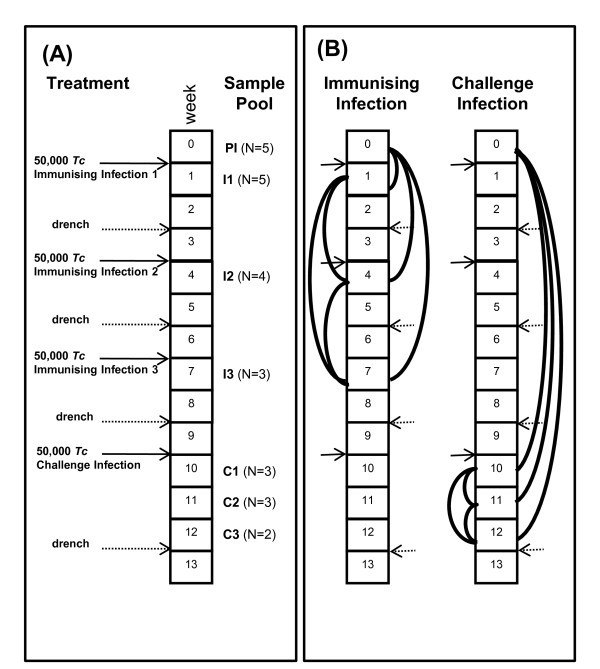
Experimental Design. (A) Truncated Immunising infection and Challenge protocol. Daily afferent lymph samples were collected over a 13 week period. RNA was pooled (sample pools) after extraction from afferent lymph samples from weeks labelled PI (Pre-infection, week 0), I1 (Immunising infection 1, week 1), I2 (Immunising infection 2, week 4), I3 (Immunising infection 3, week 7), C1 (Challenge infection, week 10), C2 (Challenge infection, week 11) and C3 (Challenge infection, week 12). N; number of animals in each sample pool, solid arrows show infection with 50,000 T. colubriformis (Tc) and dashed arrows show drench treatment. (B) Hybridisation of RNA pools. Solid lines show the comparisons made; solid arrows show nematode infection and dashed arrows show drench treatments.